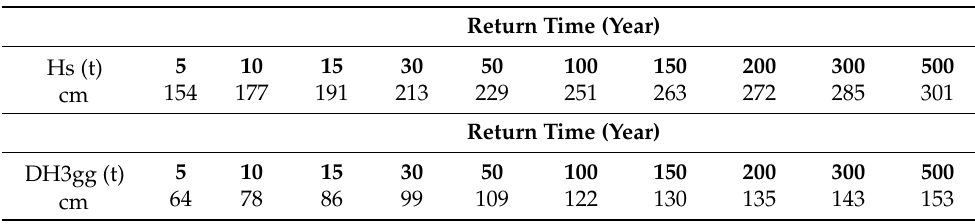
Table 3. Main nivometric parameters required for the return time estimations, recorded at the Prati di Tivo gauge (1450 m a.s.l.). N.B.: Hs is the height of the snow cover and DH3gg is the increase of the snow cover height over three consecutive days.